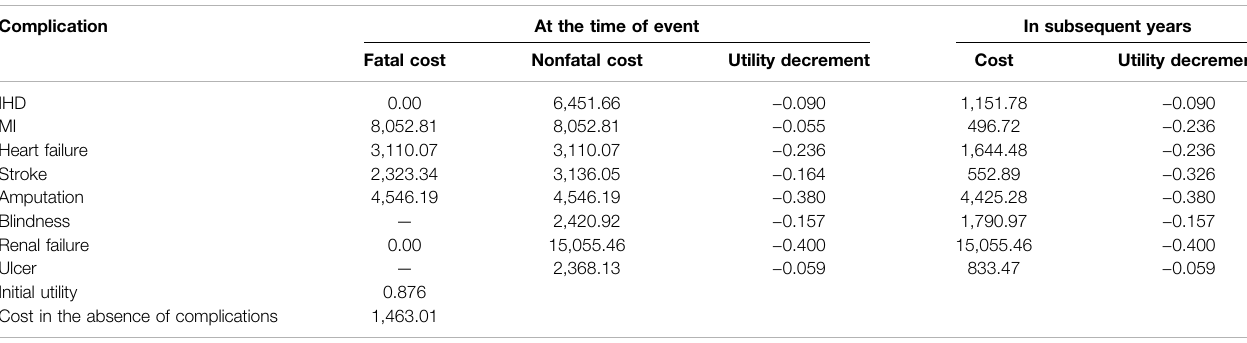
TABLE 4 | Key model inputs of costs and